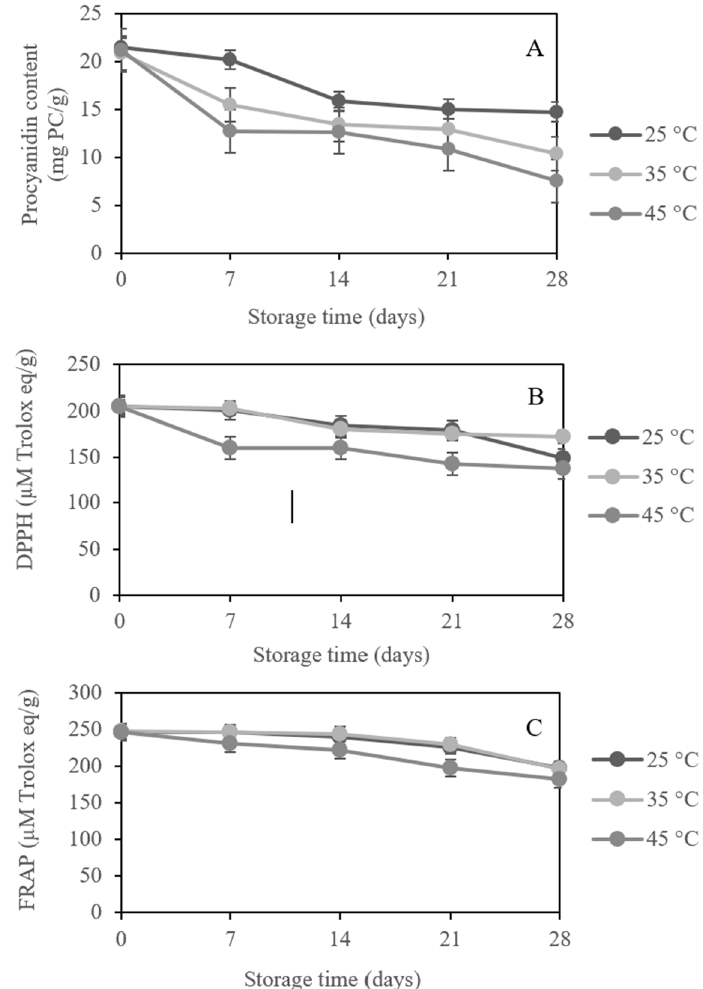
Figure 2. Changes in the procyanidins ( A ), DPPH radical scavenging activity ( B ), and FRAP radical scavenging activity ( C ) of GSS extract powder over 28 days at various storage temperatures.